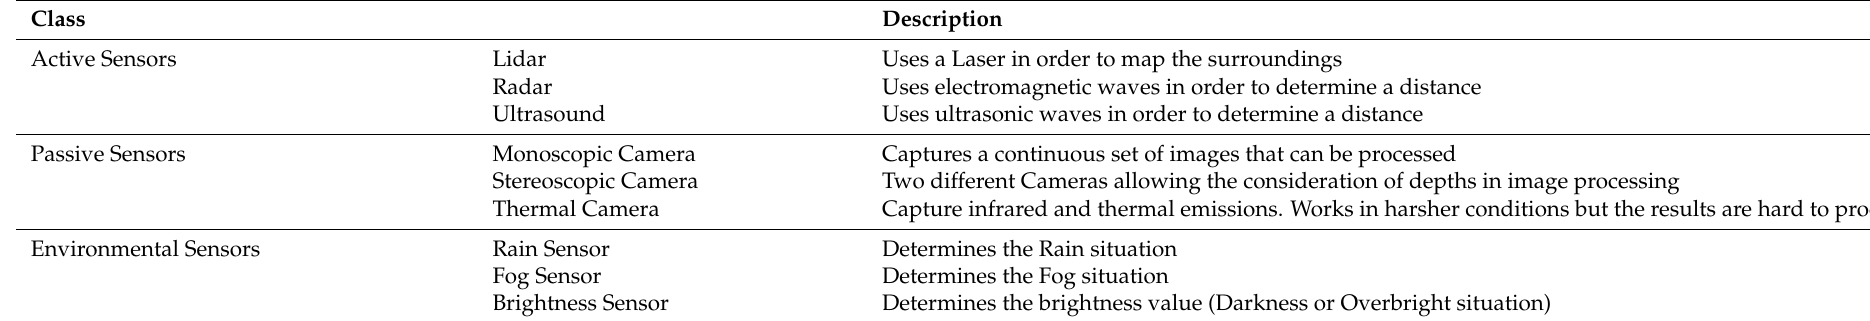
Table A2. More details on the Sensors